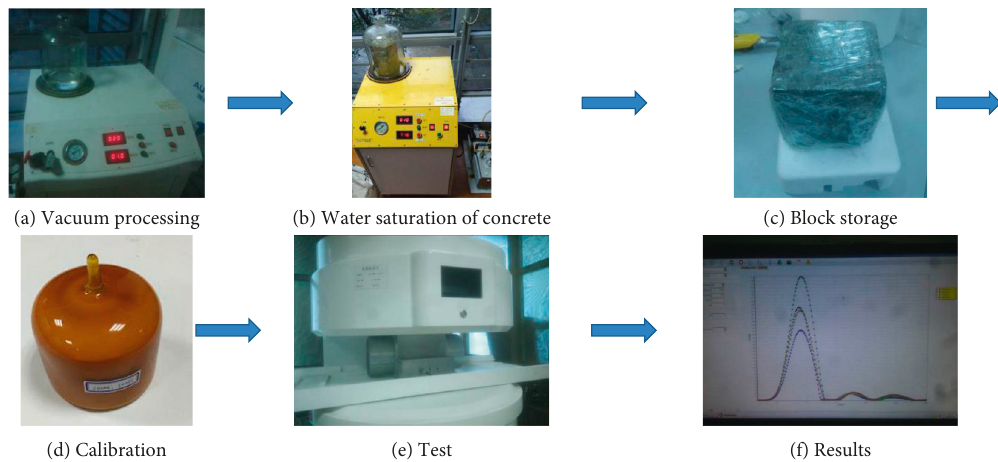
Figure 5: Preparation and procedures of NMR testing. (a) Vacuum processing. (b) Water saturation of concrete. (c) Block storage. (d) Calibration. (e) Test. (f) Results.